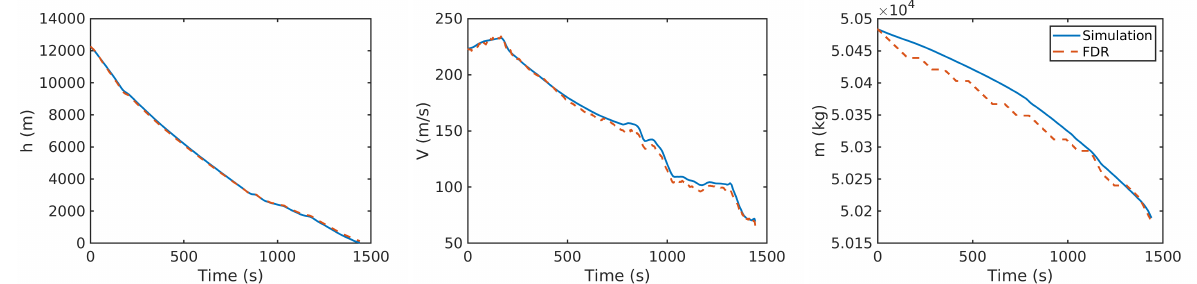
Figure 3. Validation of the aircraft trajectory simulation code for the descent phase. Comparison between simulated and FDR data.